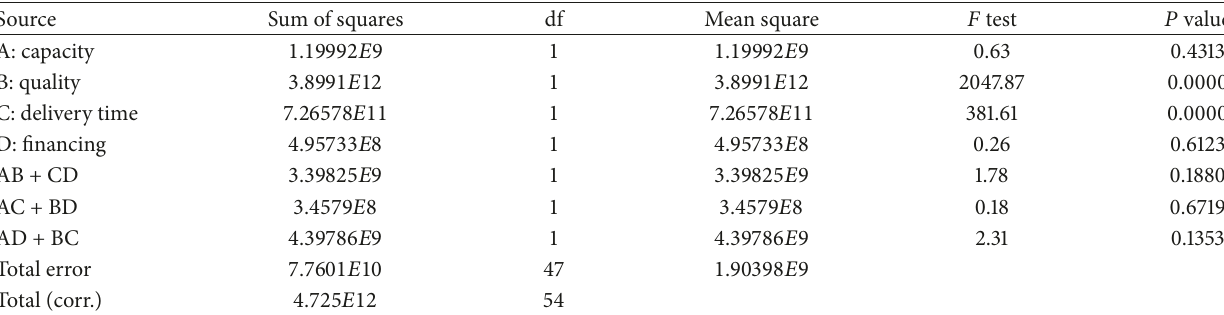
Table 2: Analysis of variance for profit of each scenario.